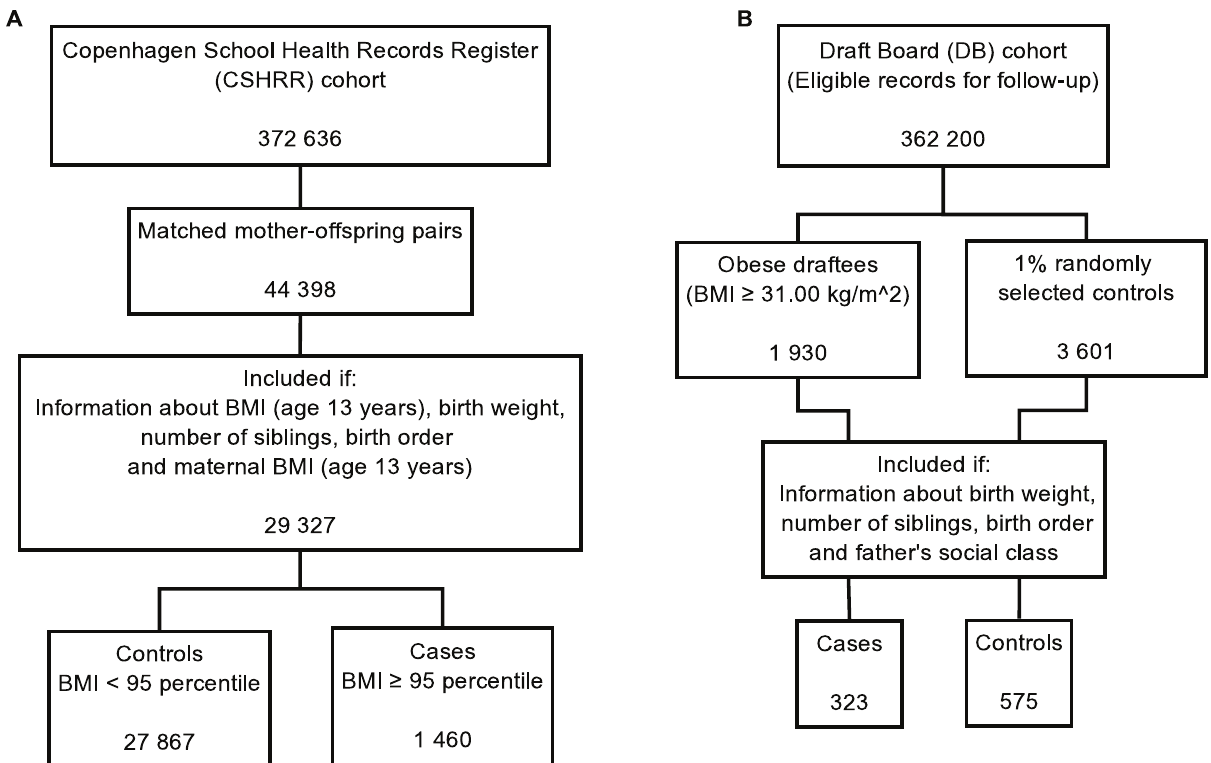
Figure 1. Flow-charts of the two sample selections based on eligibility and exclusion criteria.